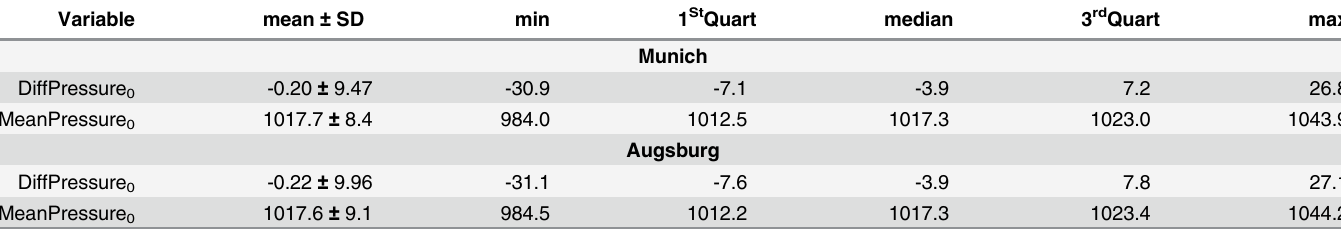
Table 2. Atmospheric pressure parameters in hPa for Augsburg and